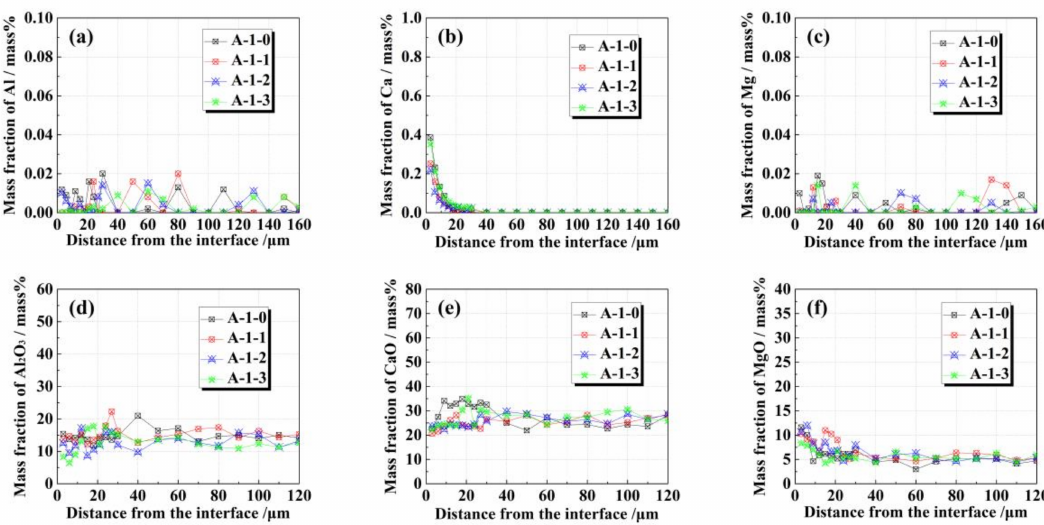
Figure 5. Compositional changes of the alloy and oxide near the interface in the A-1- x diffusion couples after isothermal heating at 1273 K for 10 h: ( a ) Al; ( b ) Ca; ( c ) Mg; ( d ) Al 2 O 3 ; ( e ) CaO; ( f ) MgO.